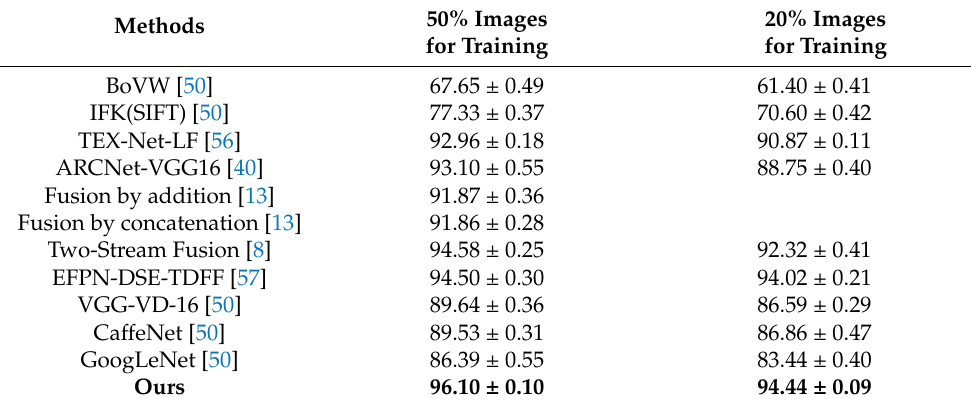
Table 3. The comparison of overall accuracy on